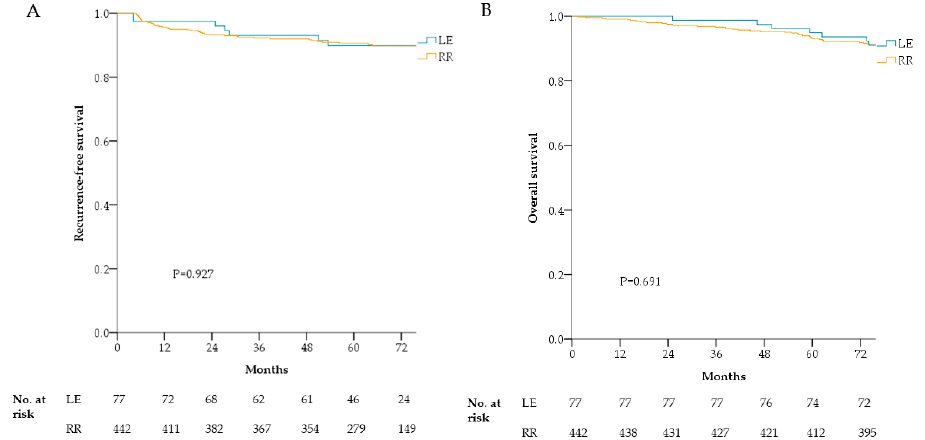
Figure 4. Oncologic outcomes according to surgical treatment of ypT0-1 rectal cancer after preoperative chemoradiotherapy. Recurrence-free survival ( A ) and overall survival ( B ). RR, radical resection; LE, local excision.